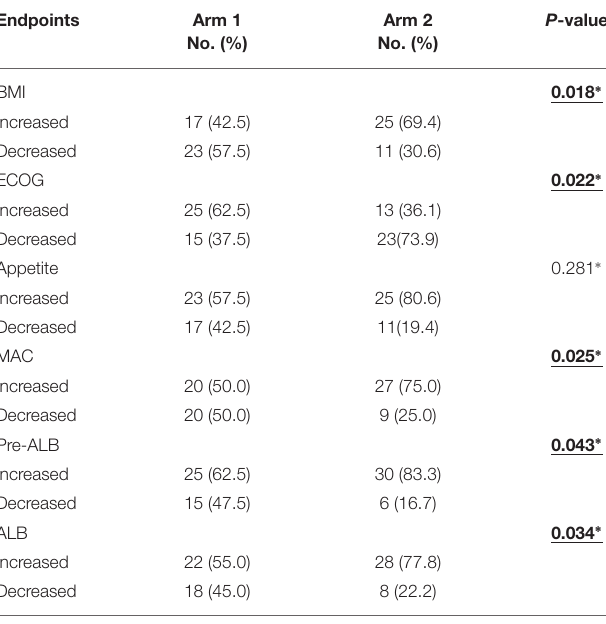
TABLE 4 | Baseline characteristics of